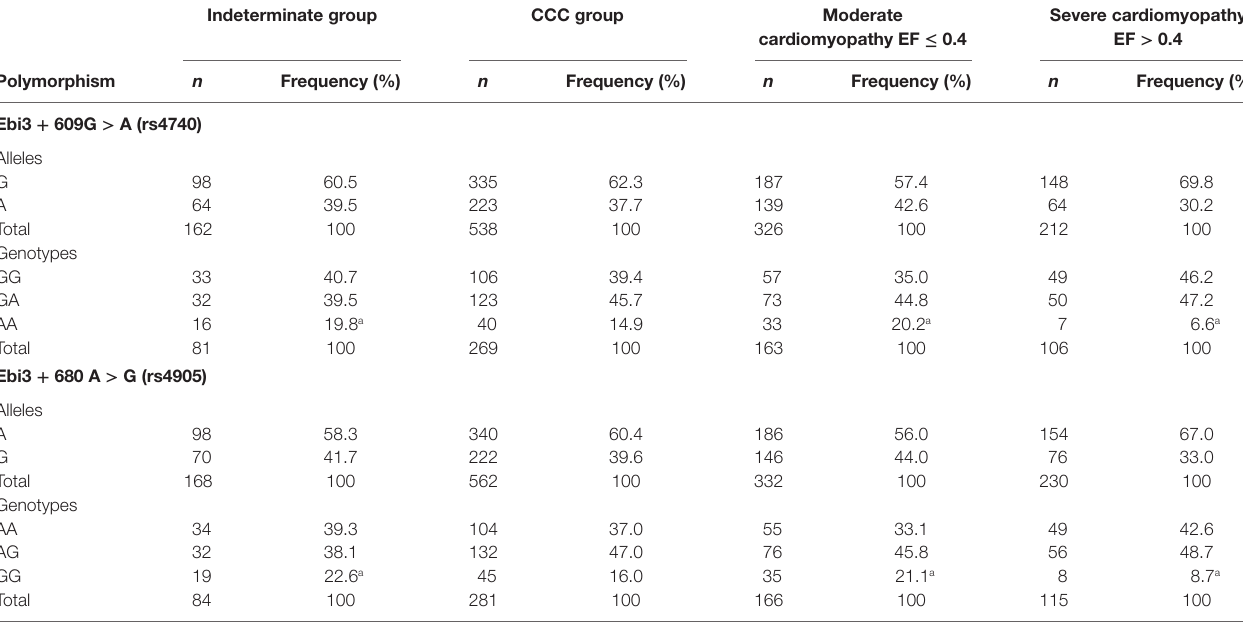
TaBle 1 | The inheritance of polymorphisms rs4740 and rs4905 at Ebi3 gene is associated with more severe cardiopathy in Chagas patients. indeterminate group ccc group Moderate